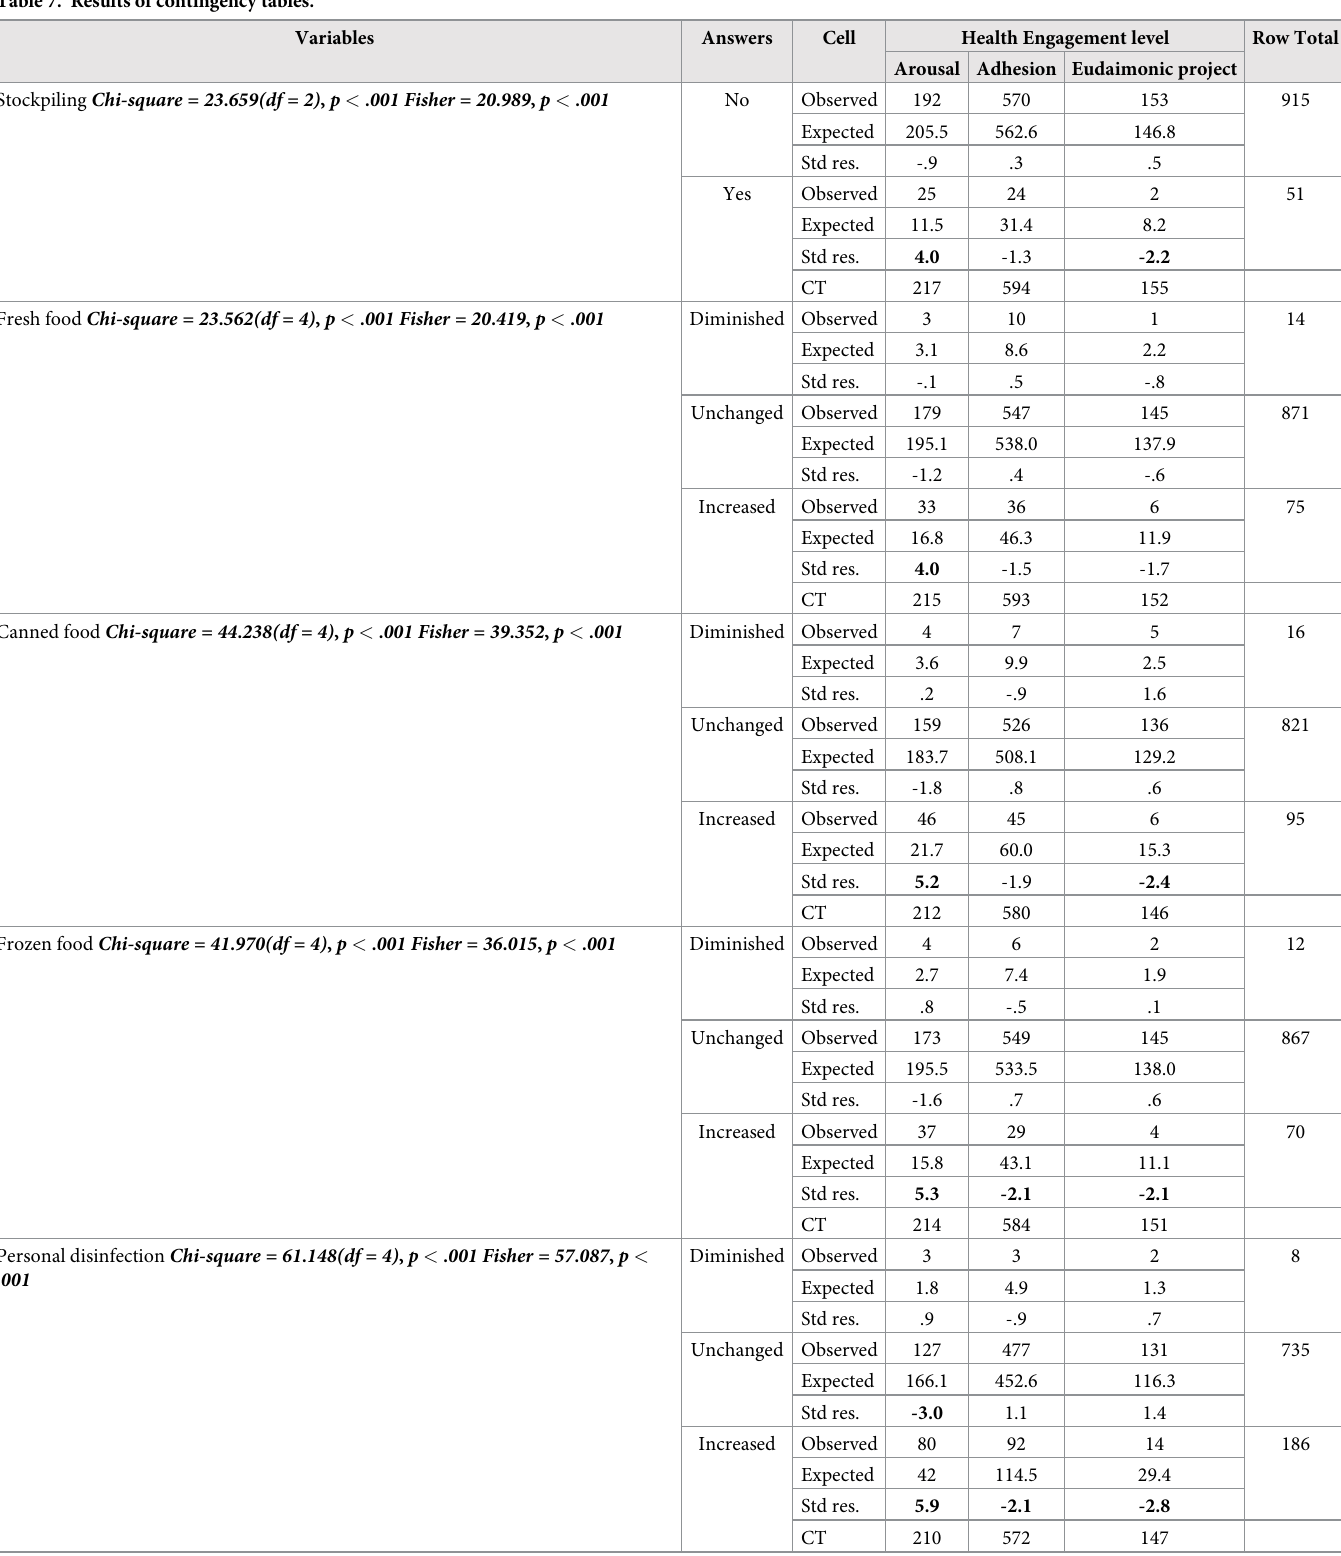
Table 7. Results of contingency tables. Variables Answers Cell Health Engagement level Row Total